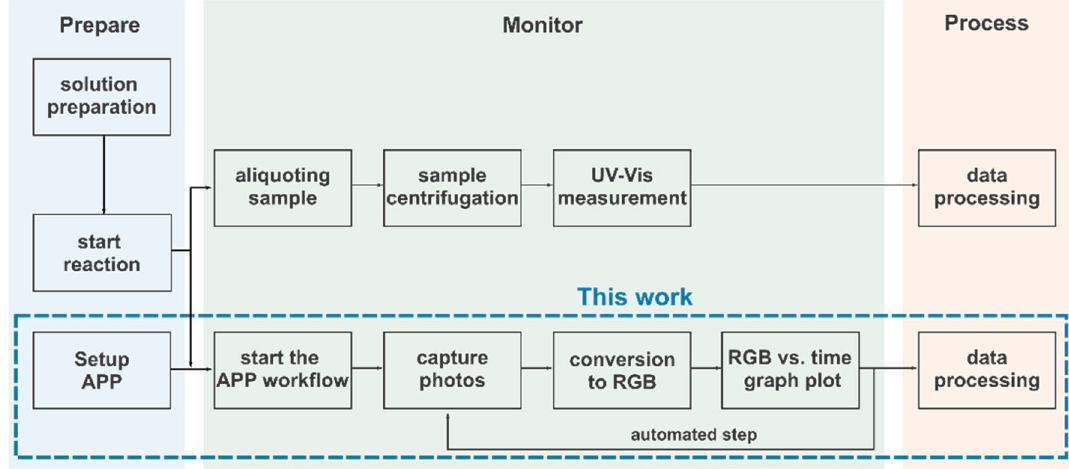
Figure 1. Experimental kinetic monitoring workflow